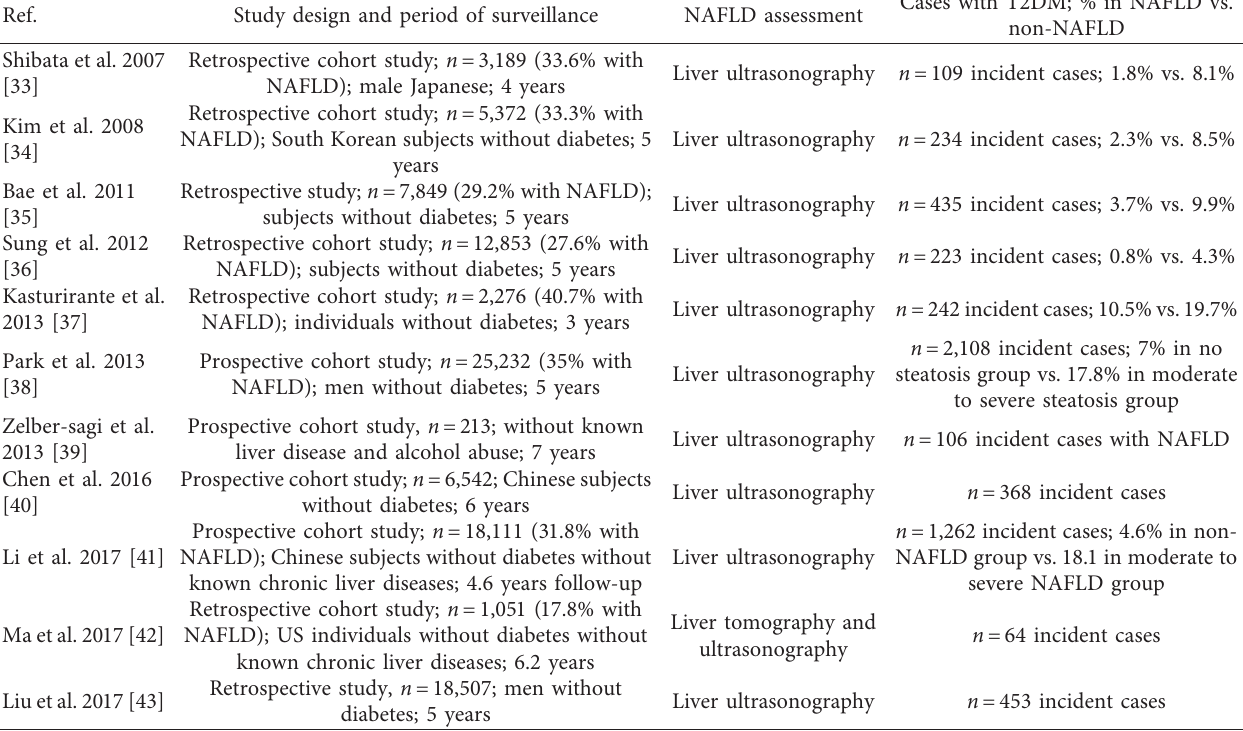
Table 1: Studies which assessed T2DM incidence among patients with NAFLD. Ref.